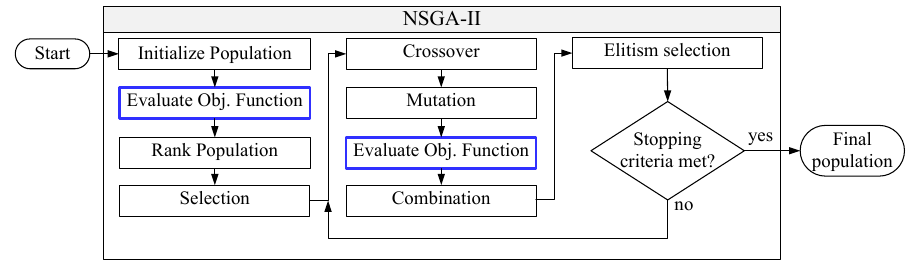
Figure 9. Non-dominated sorting genetic algorithm II (NSGA-II) process flowchart. Energies 2020 , 13 , x FOR PEER REVIEW